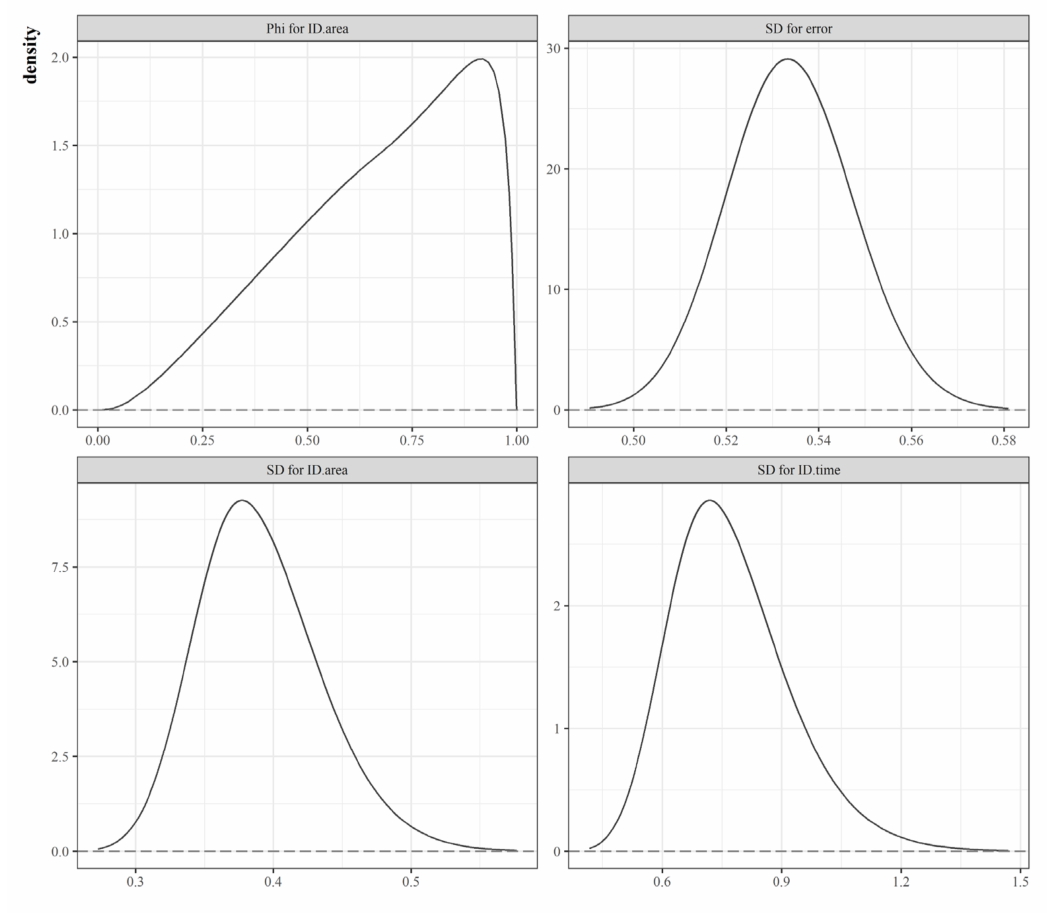
Figure 5. Marginal posterior distribution of